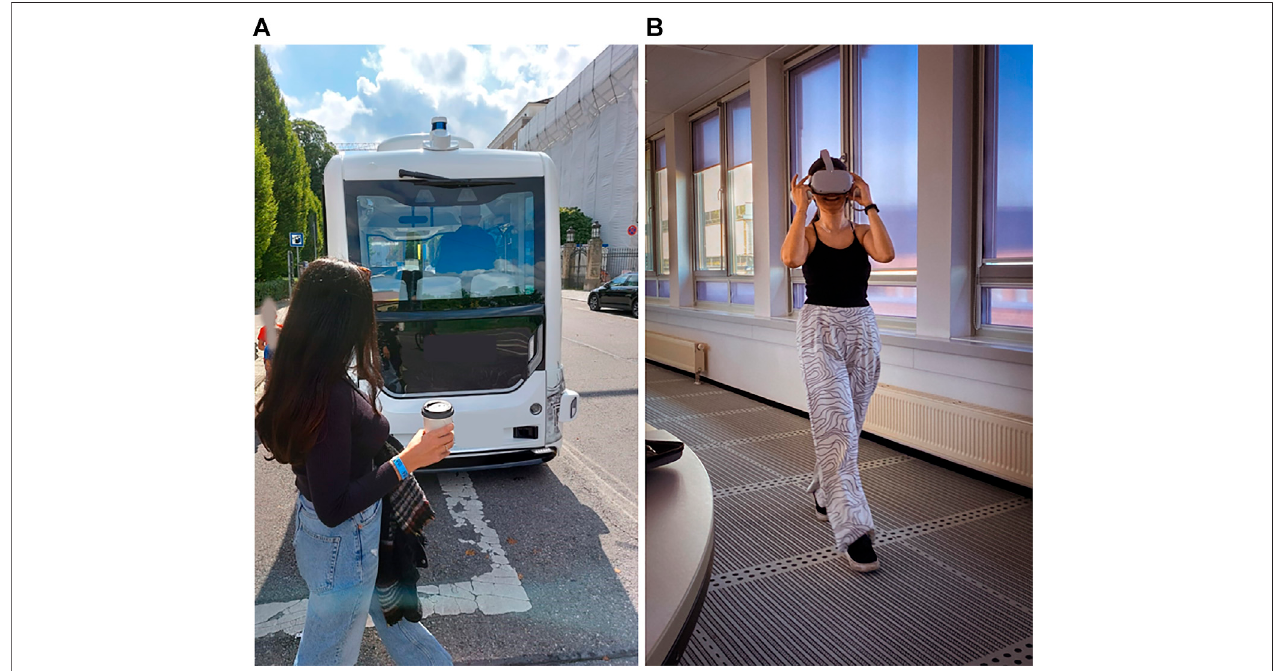
FIGURE 1 | Human – AV interaction in everyday traf fi c and in pedestrian simulators. (A) In the future, pedestrians will interact with AVs with higher levels of automation daily. (B) VR enabled us to utilize our meeting room with a long corridor for a safe testing environment for our pedestrian simulator.